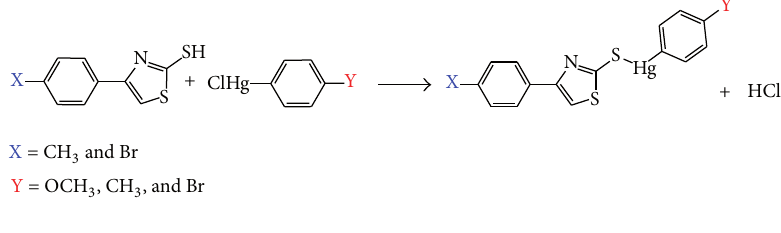
F 4: Synthetic route for the aryl thiazolyl mercury (II) derivatives